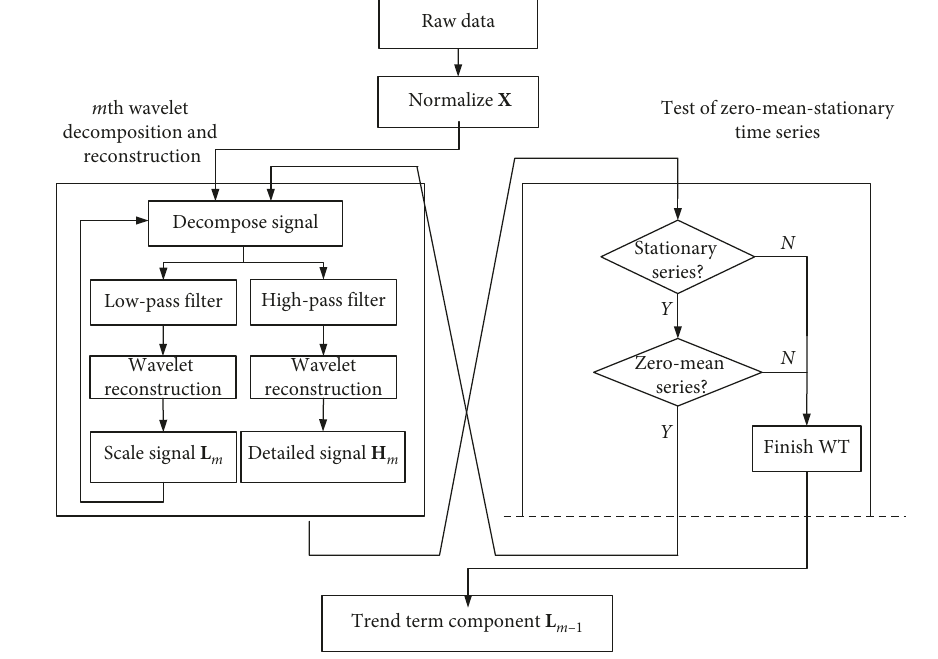
Figure 2: Illustration of the trend extraction algorithm.